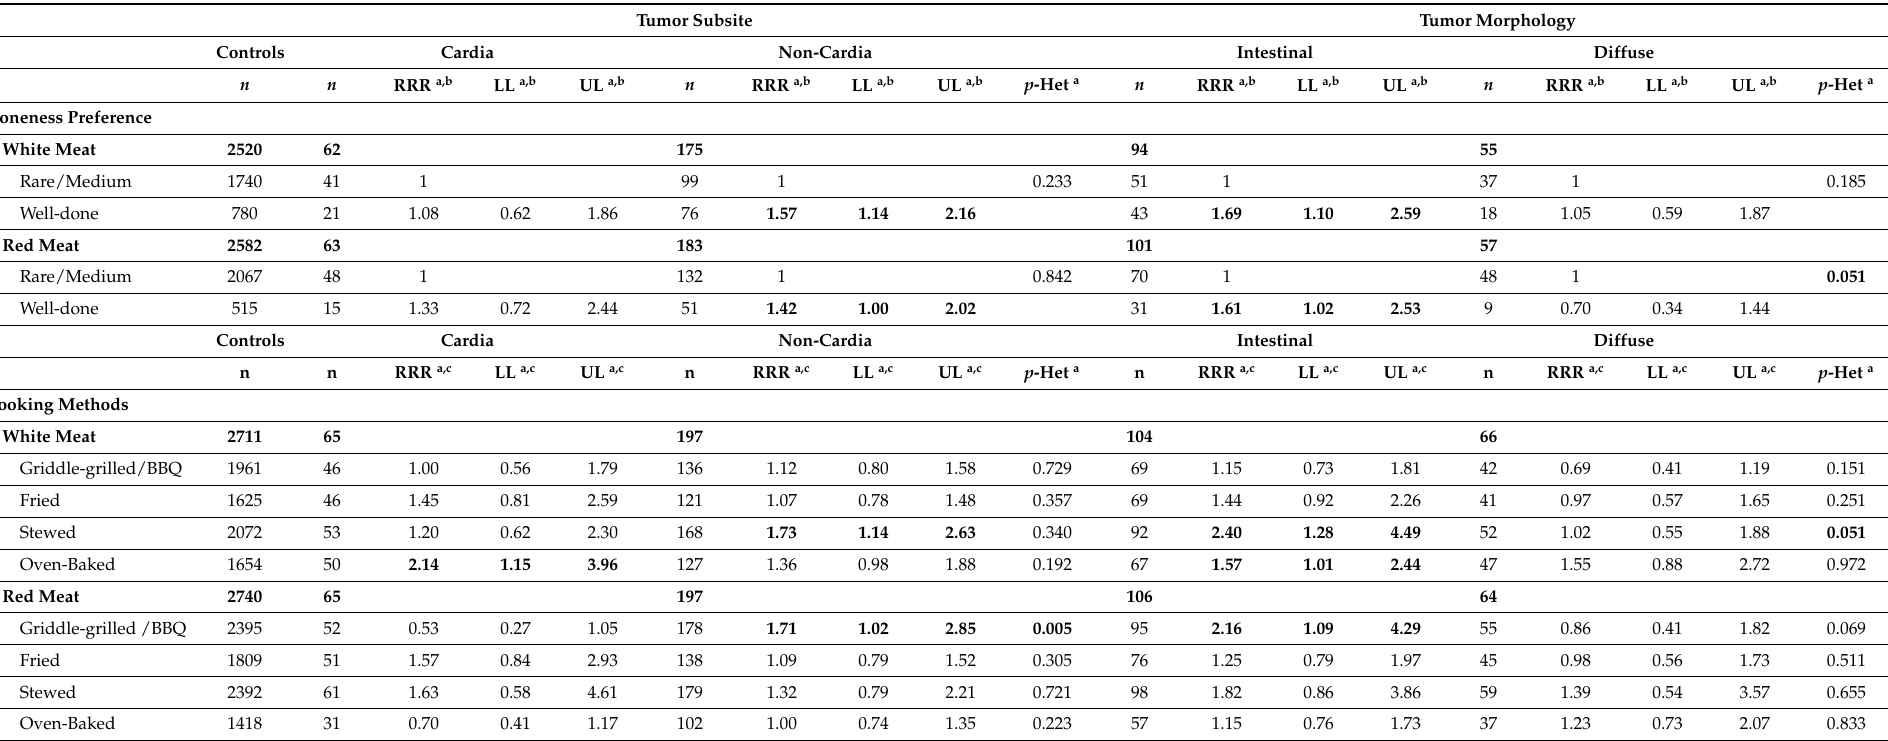
Table 6. Association between gastric adenocarcinoma incidence and meat-type specific doneness preference and cooking methods by tumor subsite (cardia, non-cardia) and morphology (intestinal, diffuse) (restricted to consumers of each type of meat). Tumor Subsite Tumor Morphology Controls Cardia Non-Cardia Intestinal Diffuse